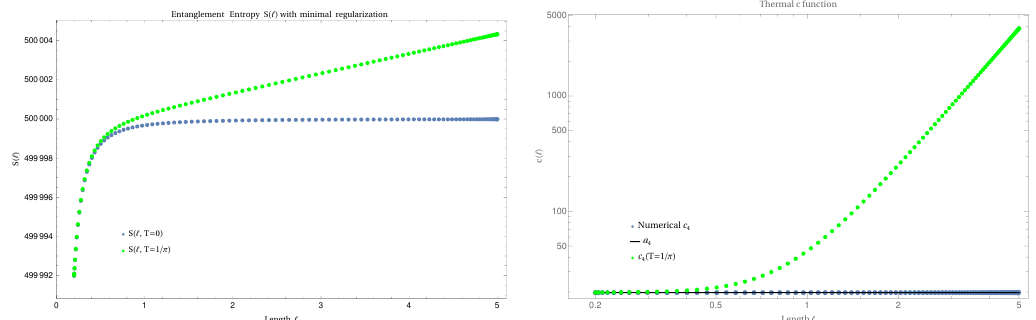
Figure 11 . The entanglement entropy and the c-function of N = 4 SYM theory as calculated in a thermal state dual to a Schwarzschild black brane in asymptotically AdS 5 spacetime. Both are displayed as a function of the probed length scale, ‘ (equivalent to z ∗ , see appendix A.3). The green curves associated with a thermal state (labeled T/π ) are displayed alongside their blue counterparts which are computed in a vacuum state ( T = 0 ). Left: the entanglement entropy, with its values regulated via minimal subtraction of the 1 /z 2 divergence. Right: the c-function evaluated in a UV thermal state increases as we decrease the probed energy scale. In the UV it takes the expected value, 2 π 2 , in agreement with the value of the central charge of N = 4 SYM theory, a 4